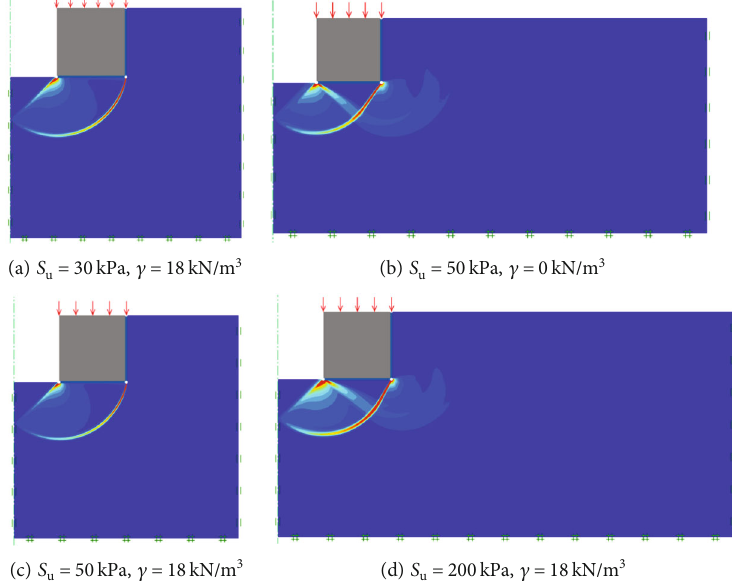
Figure 12: Failure patterns of the ring foundation under di ff erent working